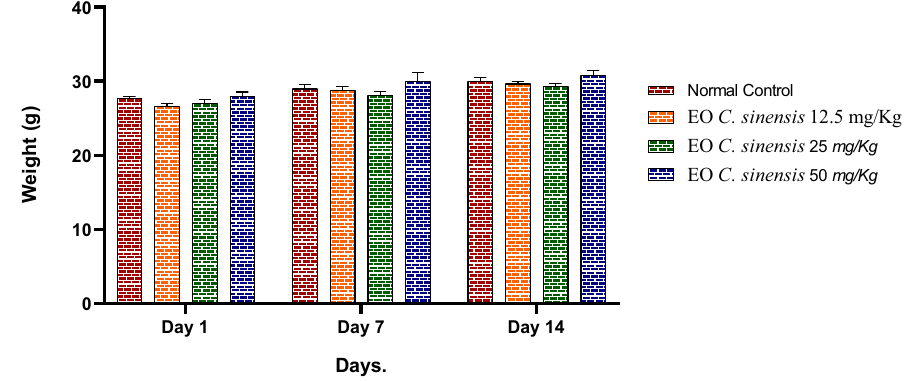
Figure 6: Bodyweight development during acute toxicity assessment in mice. The values are expressed as mean ± SD ( n = 5